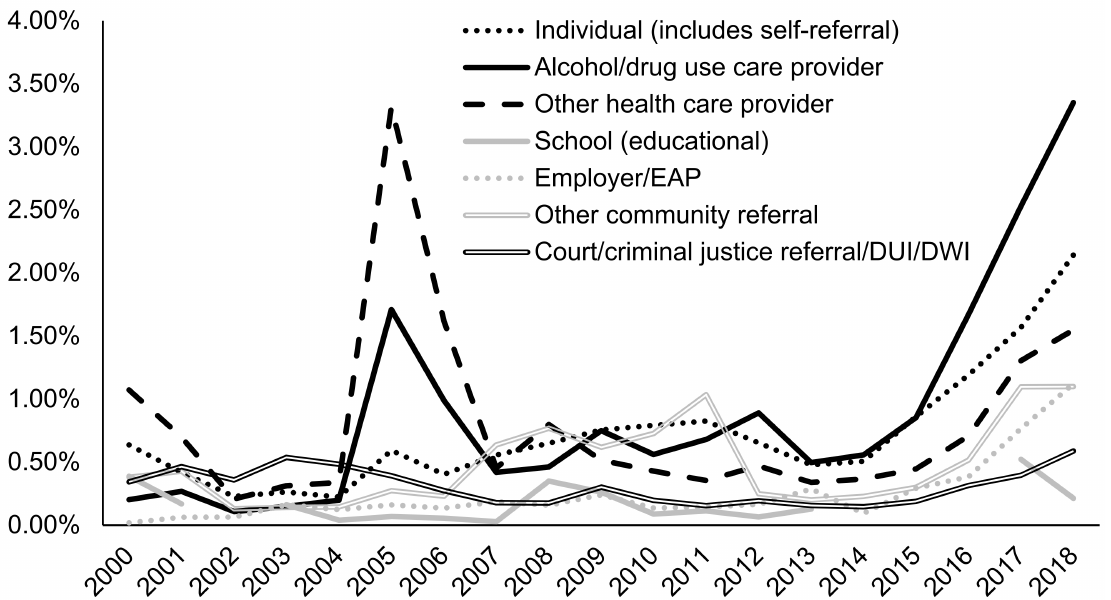
Figure 5. Prevalence of naltrexone treatment prescribed in alcohol use disorder (AUD) admissions from 2000–2018 by source of treatment referral using TEDS-A data. Temporal trends were significant by the Cochran–Armitage trend test ( p < 0.05).